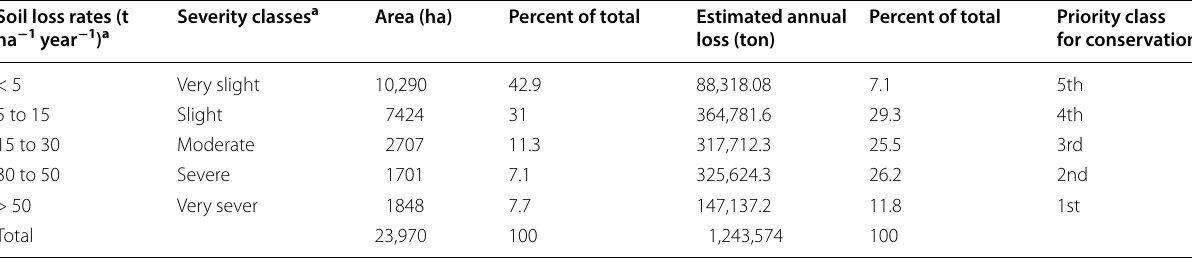
Table 6 Annual soil erosion rates, magnitude and area